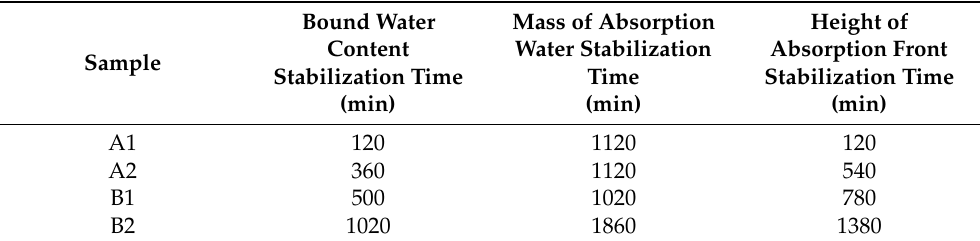
Figure 5. T 2 spectra during the capillary imbibition process in ( a ) Sample A1; ( b ) Sample A2; ( c ) Sample B1 and ( d ) Sample B2. Table 4. Stabilization time for bound water content (Figure 6), water-absorption mass (Figure 2), and height (Figure 3) of the four